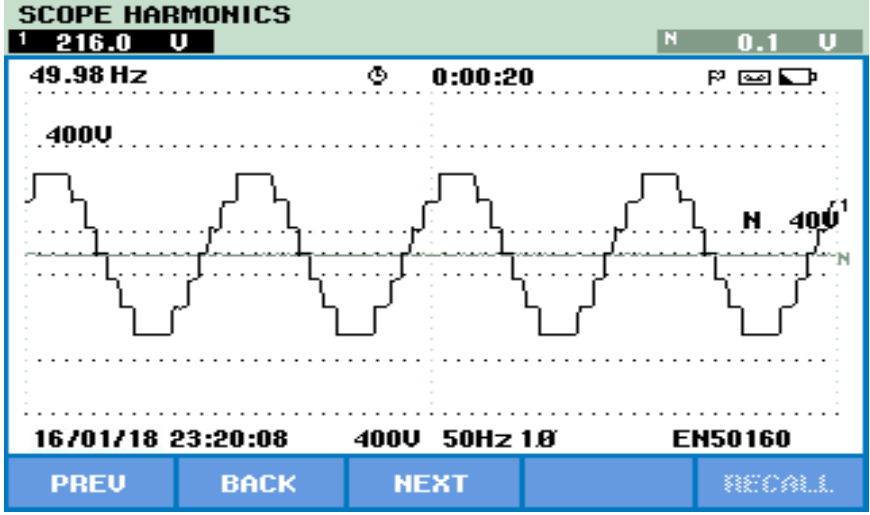
Figure 32. TLBDCLCHB inverter output using the SPWCAD technique.